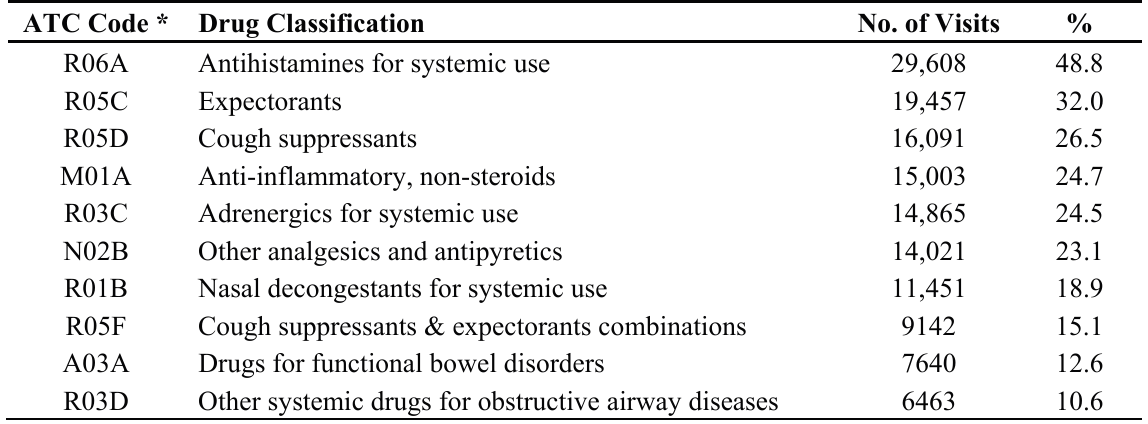
Table 5. Top ten drug classes prescribed by pediatricians, data from Taiwan’s National Health Insurance in 2012 (sampling rate: